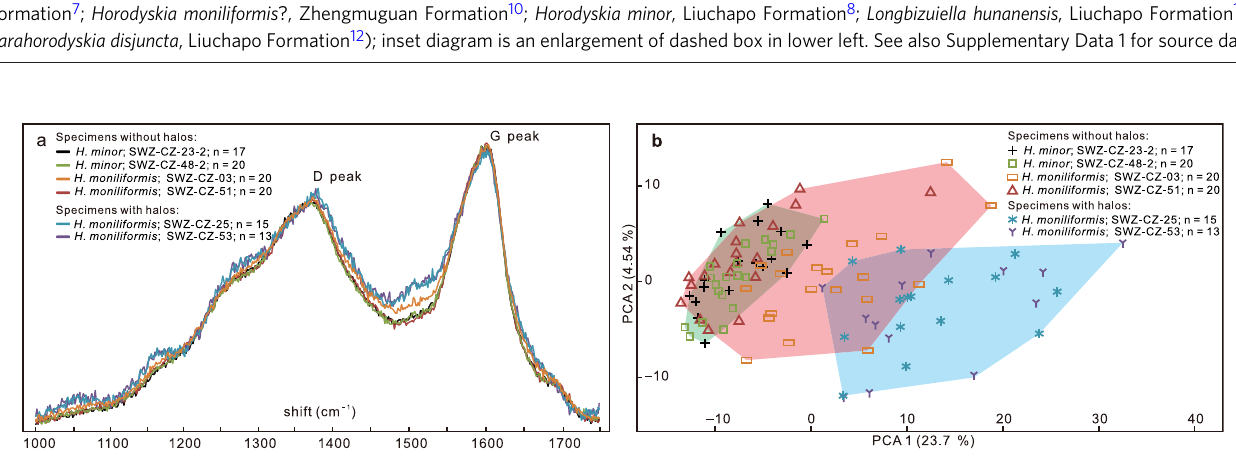
Fig. 6 Biometric analysis of Horodyskia . a Frequency distribution of bead diameter for Shiwangzhuang material; cartoon in upper right illustrates morphometric measurements in this study. b Cross-plot of average bead diameter versus average spacing between beads (i.e., gap between adjacent beads; sensu ref. 8 ) of Horodyskia strings for Shiwangzhuang material. c Cross-plot of average bead diameter versus average inter-bead distance of